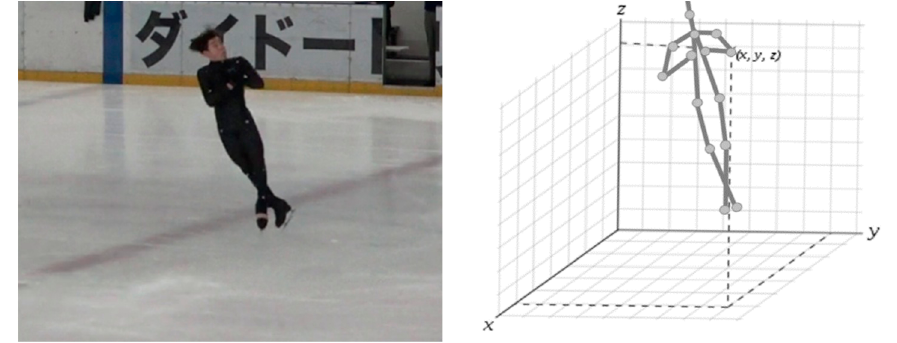
Figure 1. A frame belonging to the jump and the corresponding 3D pose.